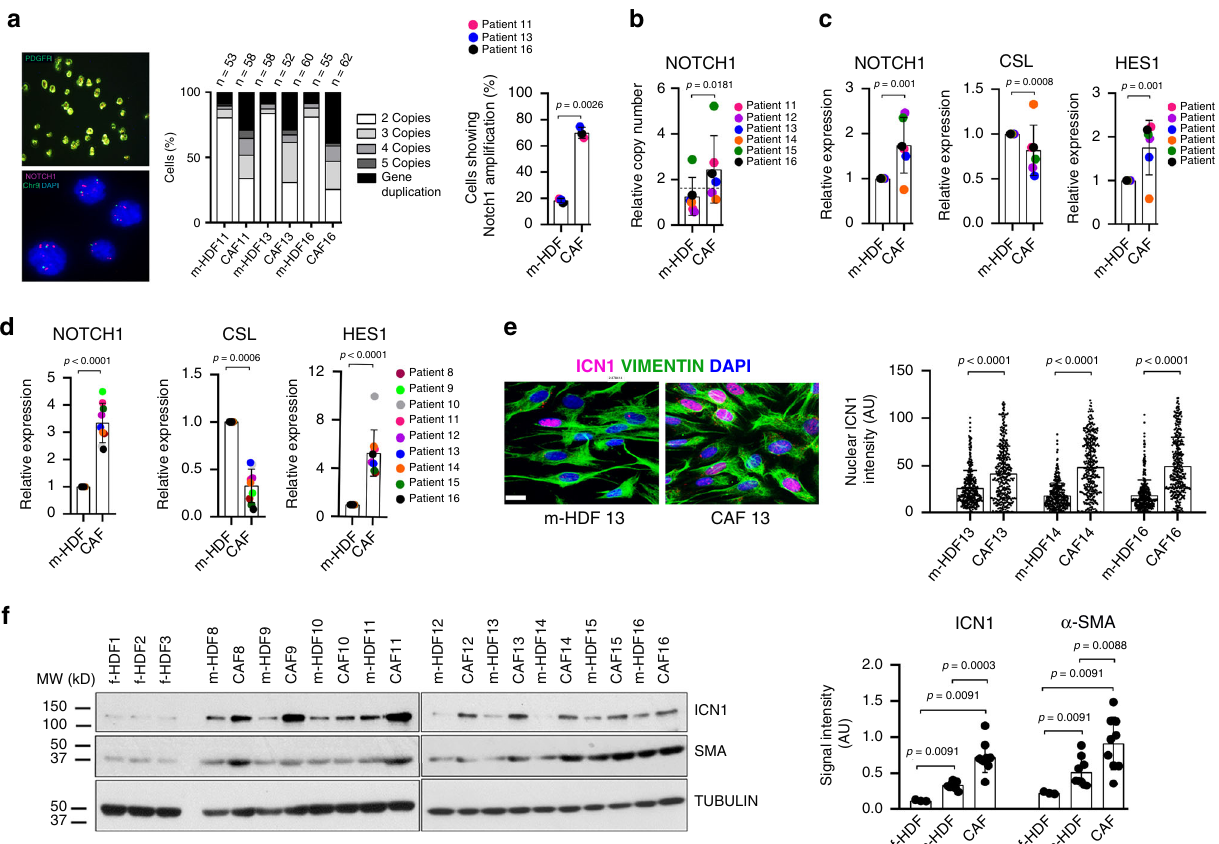
Fig. 2 NOTCH1 gene ampli fi cation and overexpression in CAFs. a Fluorescence-guided laser capture micro-dissection (LCM) followed by FISH analysis of NOTCH1 gene copy number in fi broblasts (PDGFR α positive) of SCC lesions versus unaffected fl anking skin from the same patients. Representative images and quanti fi cation of percentage of cells with NOTCH1 copy number variations. Frozen blocks of SCC samples were the same from which CAFs analyzed in Fig. 1d were derived. The number of analyzed nuclei (n) obtained from two independent experiments are shown on top of the corresponding bar. Overall quanti fi cation and statistical signi fi cance of percentage of cells with NOTCH1 ampli fi cation in CAFs versus m-HDFs from three different patients. Mean ± s. d. Two-tailed paired t -test, ** p < 0.01. n (patients, CAF) = 3, n (patients, m-HDF) = 3. Additional representative images are shown in Supplementary Fig. 1a. b LCM followed by qPCR analysis of NOTCH1 gene copy number in fi broblasts (PDGFR α positive) from SCC lesions (CAF) and unaffected fl anking skin (m-HDF) of same patients as in Fig. 1d, compared to similarly captured cells from three unmatched healthy donors. Mean ± s.d. Two-tailed paired t -test, * p < 0.05. n (patients, CAF) = 6, n (patients, m-HDF) = 6, and n (healthy donor, f-HDF) = 3. c LCM followed by RT-qPCR analysis of NOTCH1 , CSL , and HES1 mRNA expression in laser-captured fi broblasts associated with SCC (CAF) versus fi broblasts from fl anking unaffected skin (m-HDFs) from the same samples as in b . Mean± s.d. One sample t -test, *** p < 0.001. n (patients, CAF) = 6, n (patients, m-HDF) = 6. d RT-qPCR analysis of NOTCH1 , CSL , and HES1 mRNA expression in early passage SCC-derived fi broblasts versus matched fi broblasts from fl anking unaffected skin from the same samples as in Fig. 1d. Mean± s.d. One sample t -test, *** p < 0.001, **** p < 0.0001. n (CAF strain) = 9, n (m-HDF strain) = 9. e Representative images and quanti fi cation of immuno fl uorescence analysis of ICN1 (magenta) coupled with VIMENTIN (green) of m-HDF and CAF strains. ICN1 signal intensity for each individual cell is indicated by scatter dot plot. Scale bar, 10 μ m. >343 cells were counted per sample. Mean± s.d, two-tailed Mann – Whitney test, **** p < 0.0001. n (CAF strain) = 3, n (m-HDF strain) = 3. f Immunoblotting with antibodies against ICN1, α -SMA, and γ -TUBULIN of f-HDFs, m-HDFs, and CAFs as in Fig. 1d. Densitometric quanti fi cation of ICN1 protein levels after γ -TUBULIN normalization. Mean ± s.d, two-tailed Mann – Whitney test, ** p < 0.0, *** p < 0.001. n (CAF strain) = 9, n (m-HDF strain) = 9, and n (f-HDF strain) =